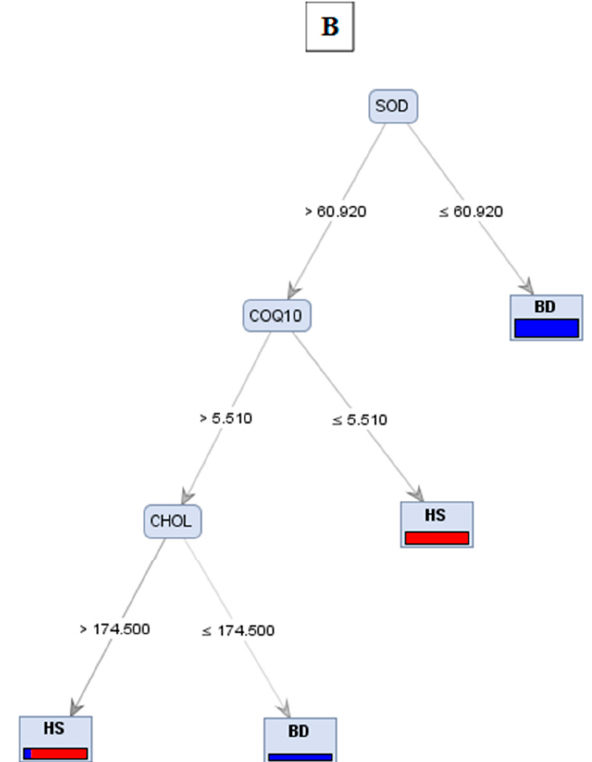
Figure 1. Predictive modeling approaches of Buerger’s disease (BD) and healthy smoker (HS) based on biomarkers analyzed in blood samples. A : decision tree linking SOD to lipid (MDA) and protein (PC) oxidation markers. B : the predictive values relating SOD to antioxidant mitochondrial markers CoQ-10 B.